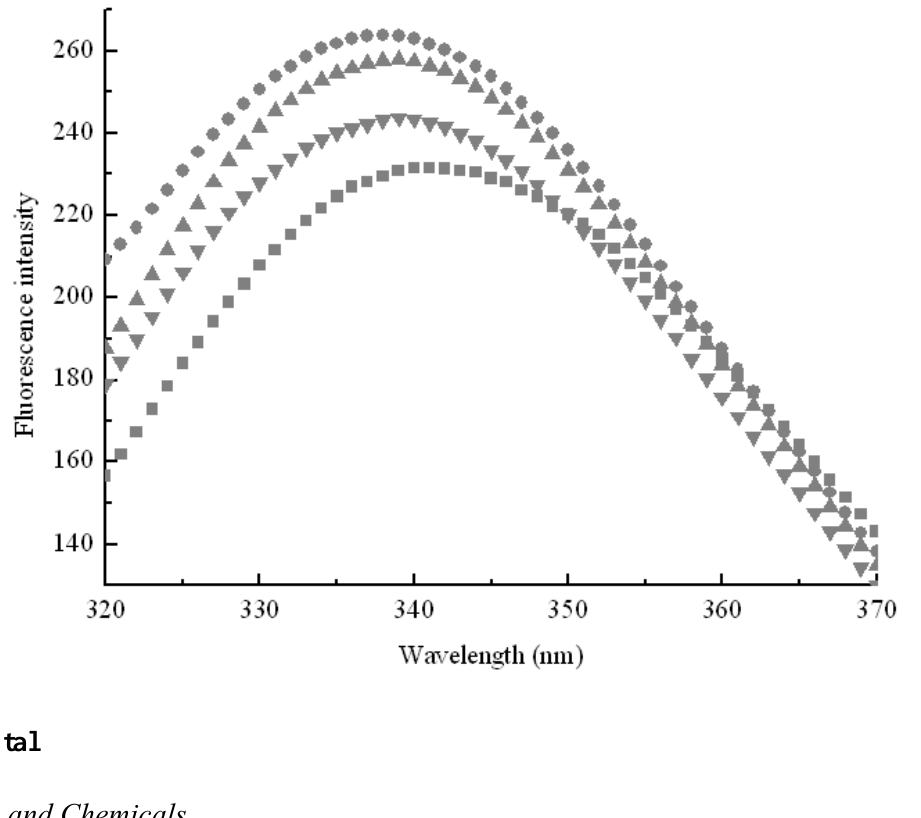
Figure 5. Effects of side chain groups of β -CD on intrinsic fluorescence of pullulanase in the absence of CDs ( ■ ) and in the presence of β -CD ( ● ), G Each data point was the mean of three